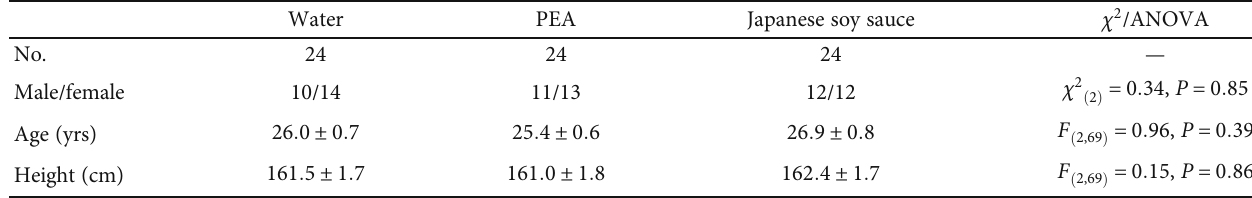
Table 1: Baseline characteristics of the three